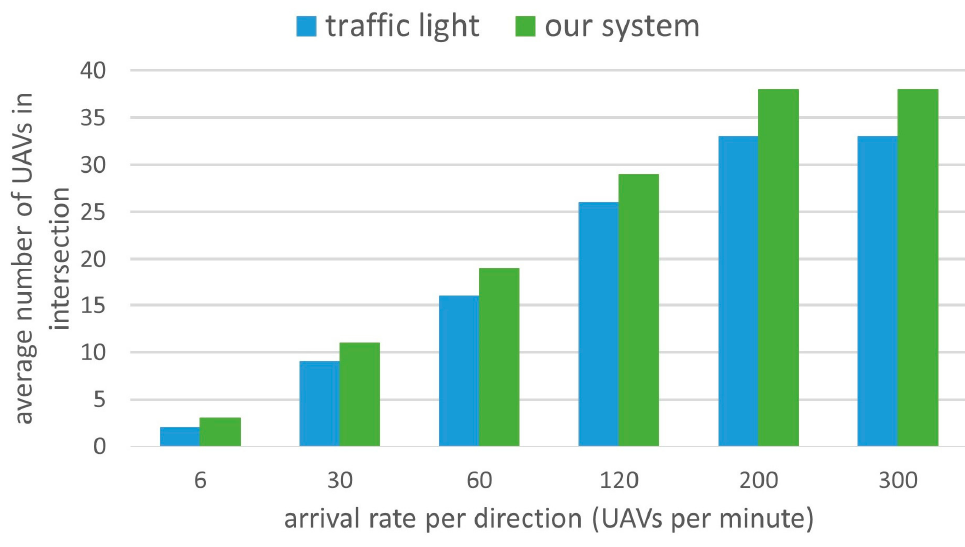
Figure 26. Average number of UAVs in the intersection using 2D optimal static traffic light and using our proposed system in 2D intersection on Scenario 1.